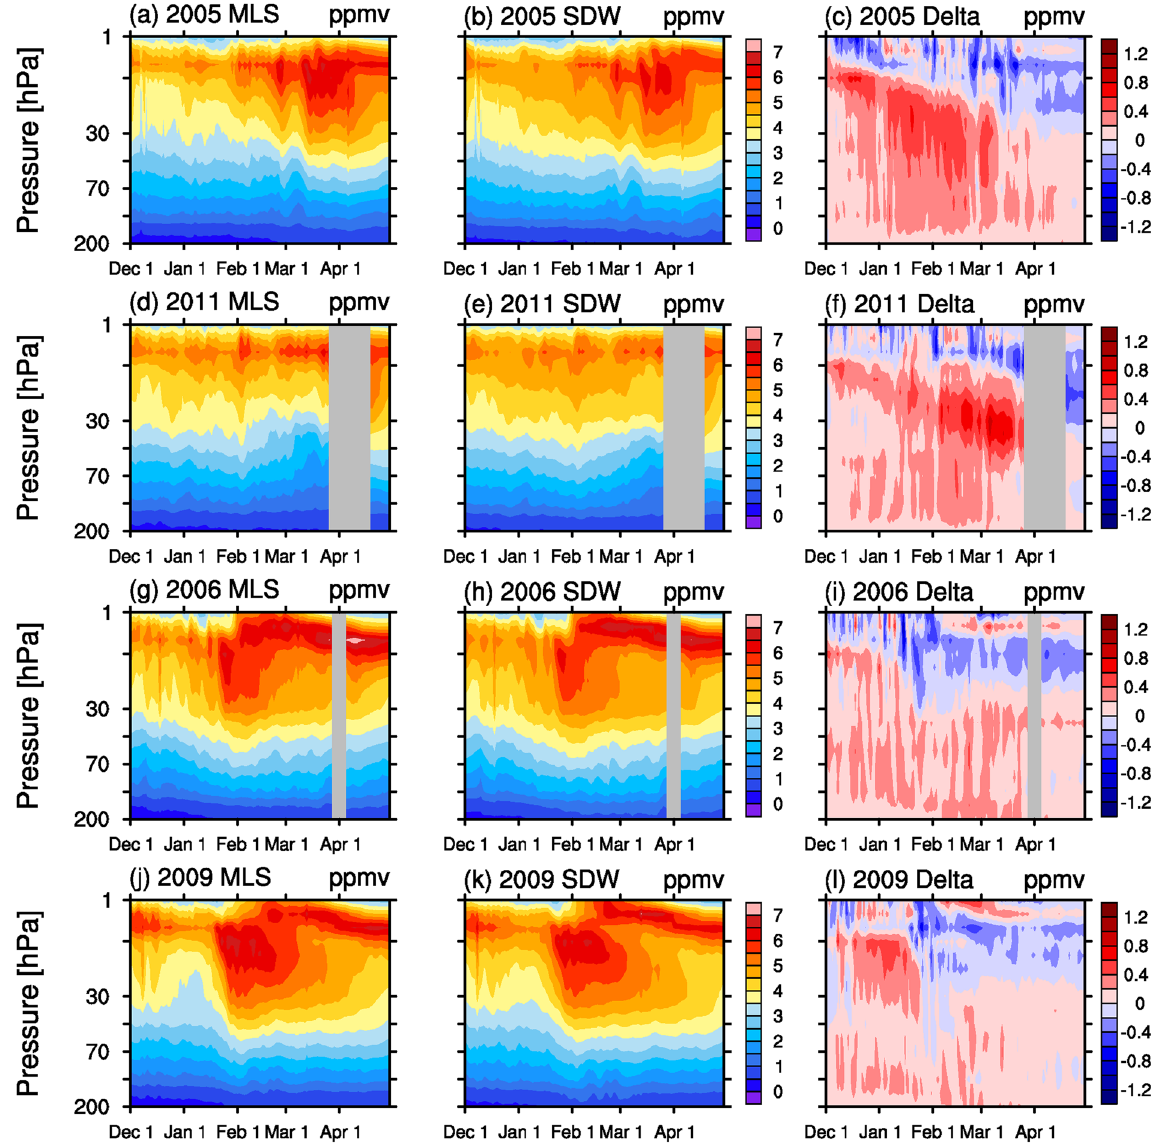
Figure 1. Evolutions of daily (left) MLS observations, (center) SD-WACCM simulations, and (right) their differences in O 3 (unit: ppmv) over the Arctic from December to April of (first row) 2005, (second row) 2011, (third row) 2006, and (fourth row) 2009. The grey areas indicate where data were either missed or acquired outside of the